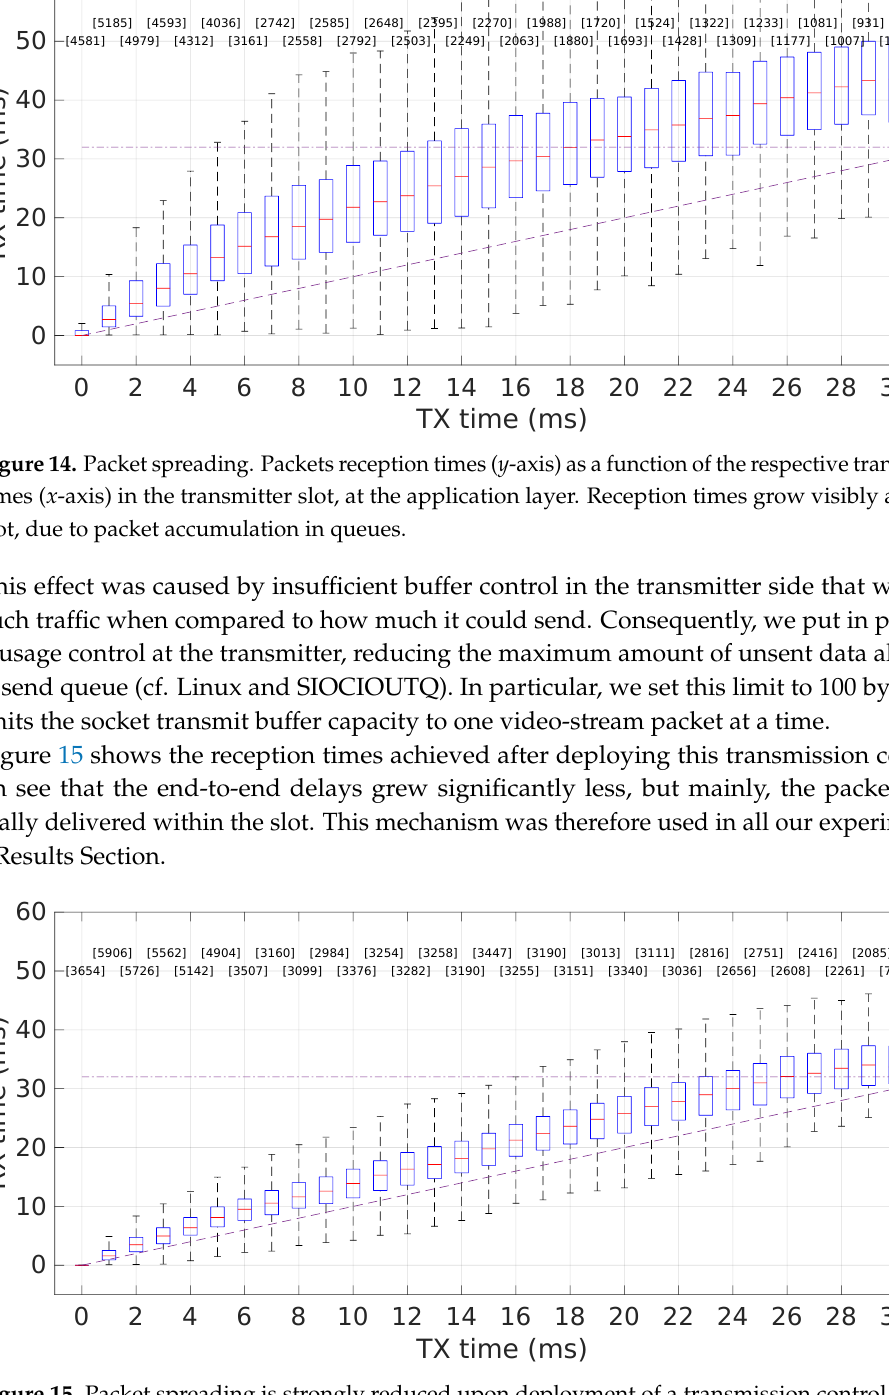
Figure 15. Packet spreading is strongly reduced upon deployment of a transmission control policy at the socket send queue level (maximum amount of unsent data allowed set to 100 B). This policy was used in the experiments reported in the Results